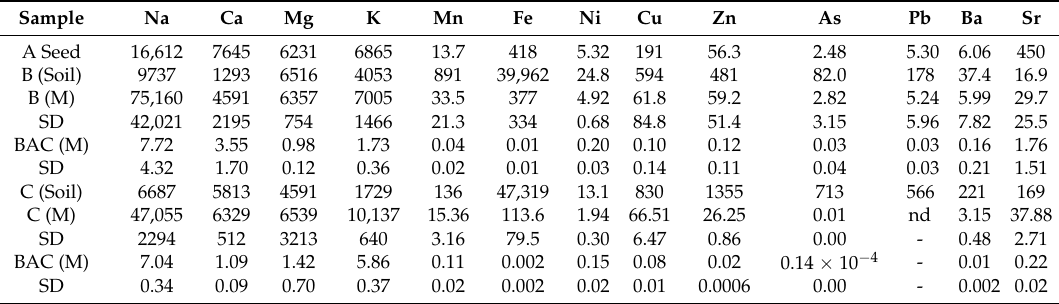
Table 1. Elemental composition of the soils and the seed and succulent stem of Sarcocornia pruinosa analyzed by ICP-MS, and the correspondent BAC values. Soil data have been extracted from the data set of Rufo et al. [13]. A sample of soil of the sampled areas (salt marsh interior and end of the river) has been selected. All data are expressed in mg/kg. M: mean; SD: Standard deviation; nd: under the detection limit. Number of samples: A (seed): n = 1; B (soil): n = 1; B (succulent stems): n = 3; C (soil): n = 1; C (succulent stems): n =